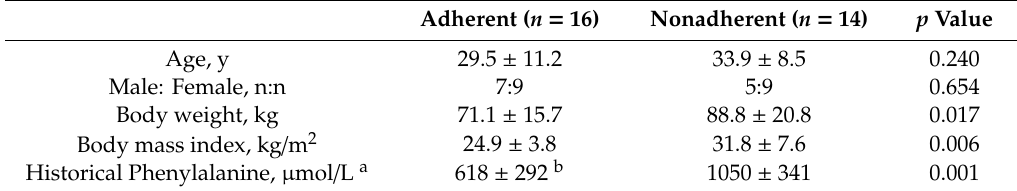
Table 1. Patient characteristics.